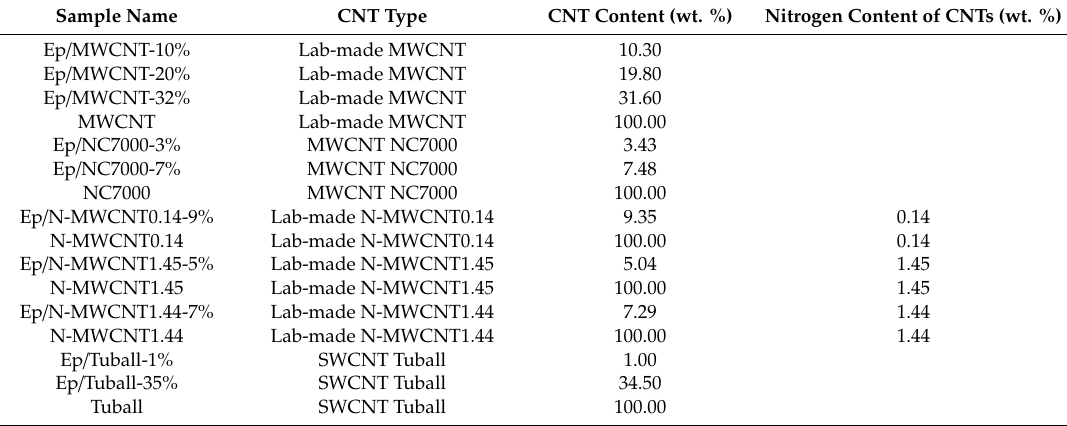
Table 1. Nomenclature of the all epoxy composites.